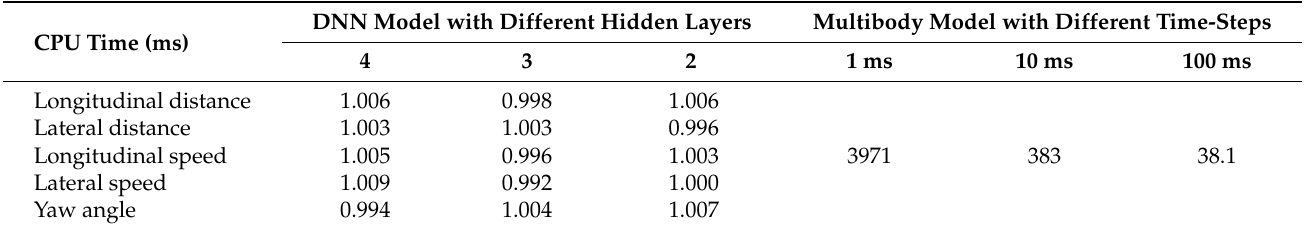
Table 3. CPU time of DNN and multibody models with different structures for 5 s dynamic simulation.